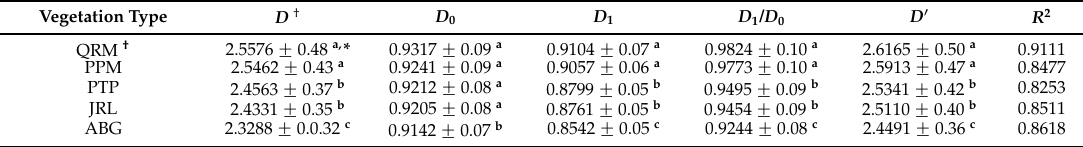
Table 3. Soil fractal dimensions under the different vegetation types in the study area.